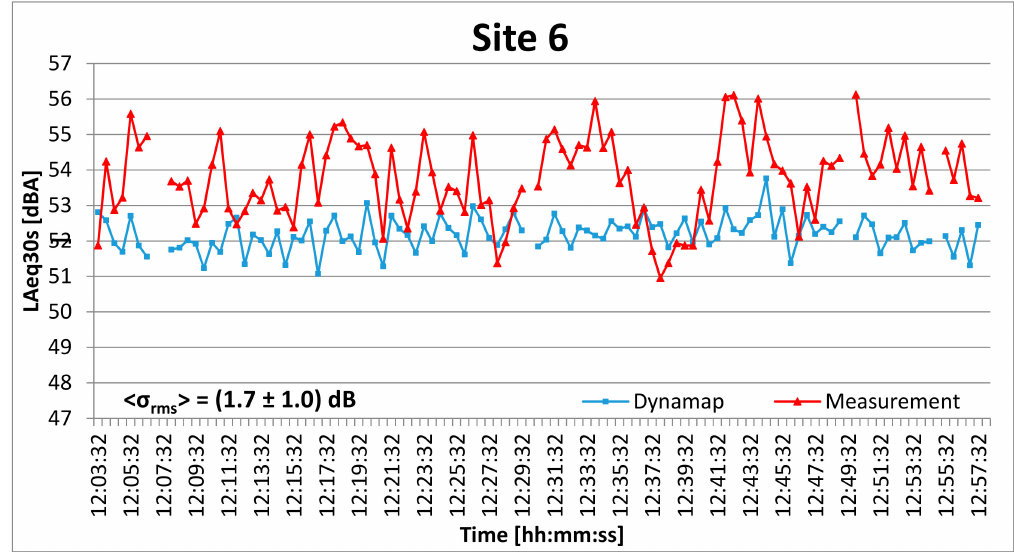
Figure 15. Comparison between DYNAMAP prediction (blue line) and measurement (red line) for Site 6 (summer 2018 campaign). On the ordinate, the A-weighted 30 s equivalent level is shown. All anomalous events have been removed from both time series.